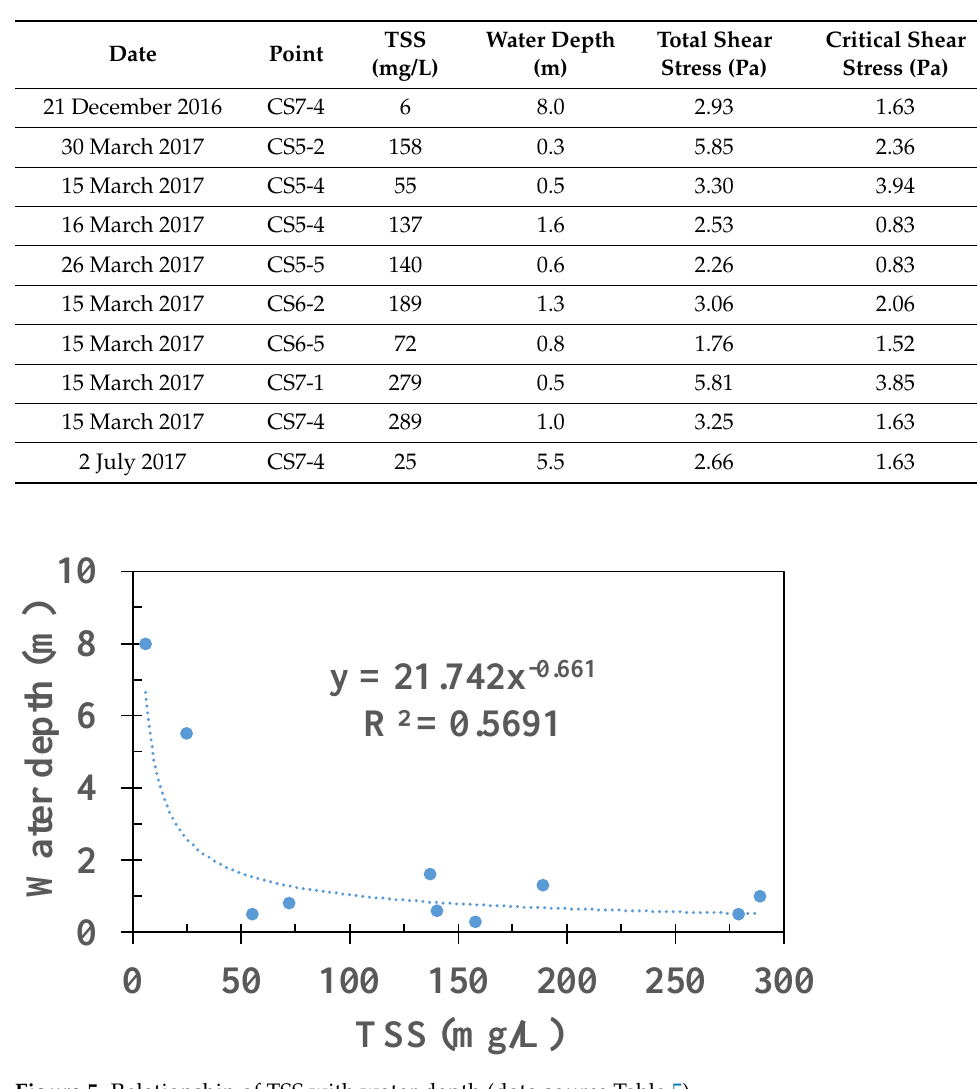
Table 6. Calculation of time to reach equilibrium TSS in Tonle Sap Lake, Cambodia. March (2017)